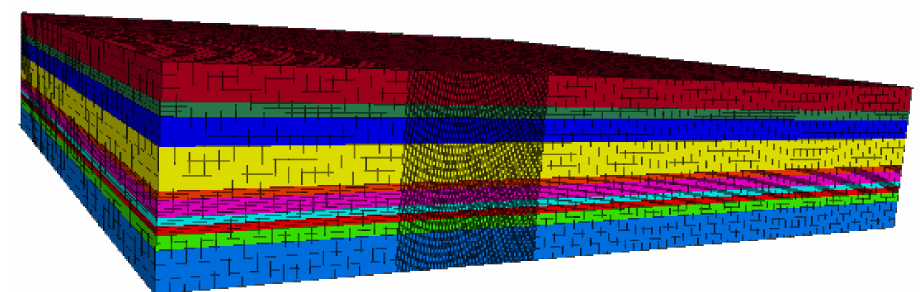
Figure 3. Numerical calculation model.